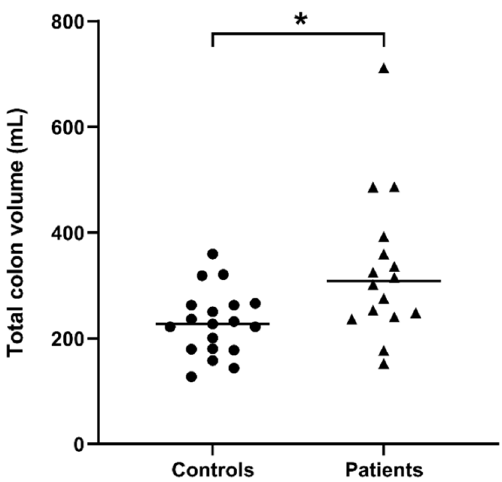
Figure 2. Total colon volume corrected for both body surface area of n = 19 controls and n = 16 patients with constipation. The horizontal lines indicate the median, * p = 0.0081 two-tailed Mann–Whitney test.